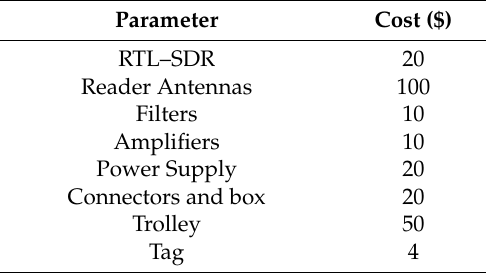
Table 2. Estimated cost of different parts of the system. SDR—software defined